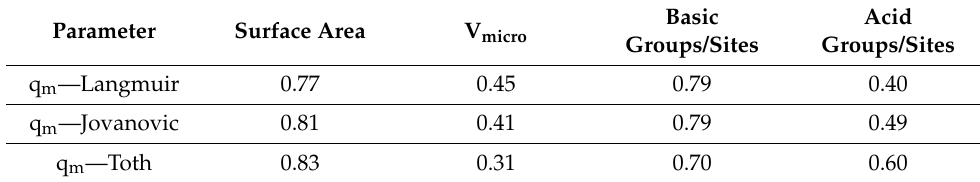
Table 12. Pearson correlation